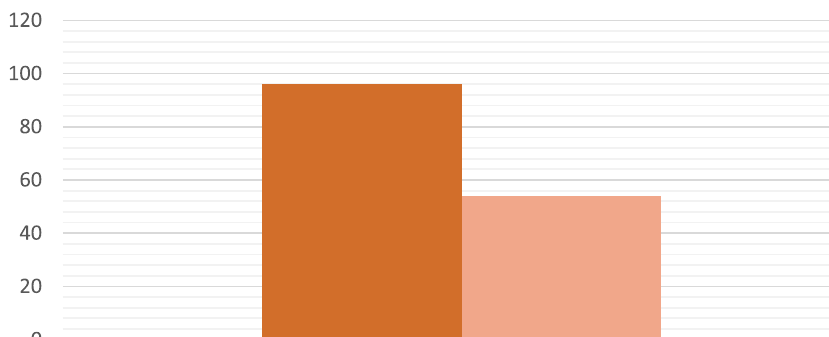
Fig. 8 Listenership strength of radio